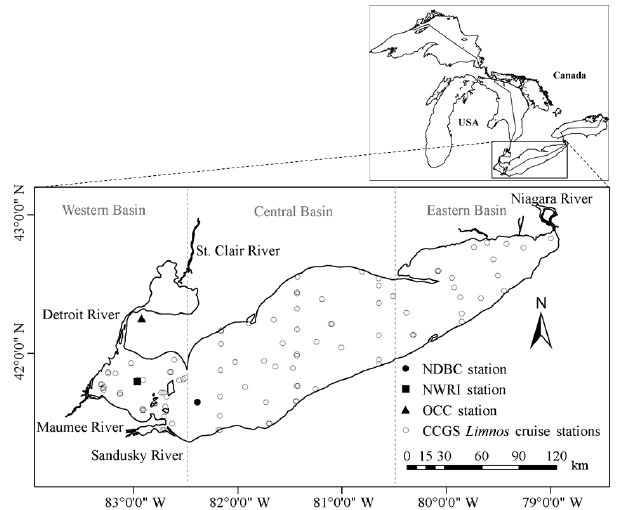
Figure 1. Maps showing Lake Erie in Laurentian Great Lakes and the location of stations where different parameters were